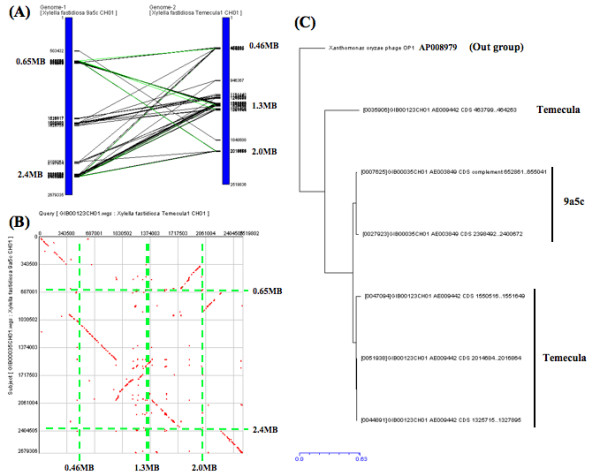
Captures of graphical result viewers. (A) BLSTCLUST. A protein-coding region on a genome is connected to coding regions for clustered proteins encoded on another genome with a line. User can select a protein-coding region on a genome, and lines connecting coding regions for members of a cluster including the selected protein are shown by green lines. (B) MegaBLAST. Identified common regions between two genomes are shown by a dot plot matrix. Green lines represent gene locations, which encode phage-related proteins in a cluster, generated with BLASTCLUST as described in text. (C) ClustalW. AP008979 is an accession number, issued by INSDC [17]. A scale bar indicates amino acid substitutions per position in the sequence.